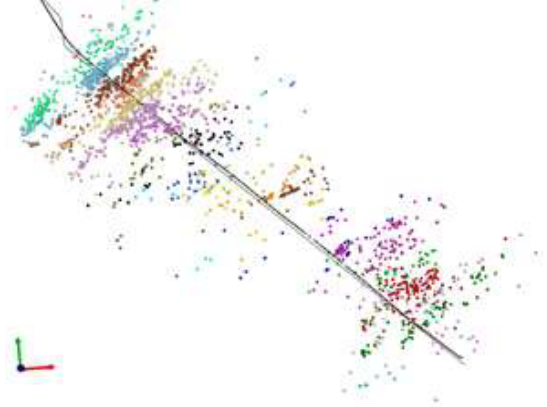
Figure 8. Microseismic signals for the each of stages in target well.